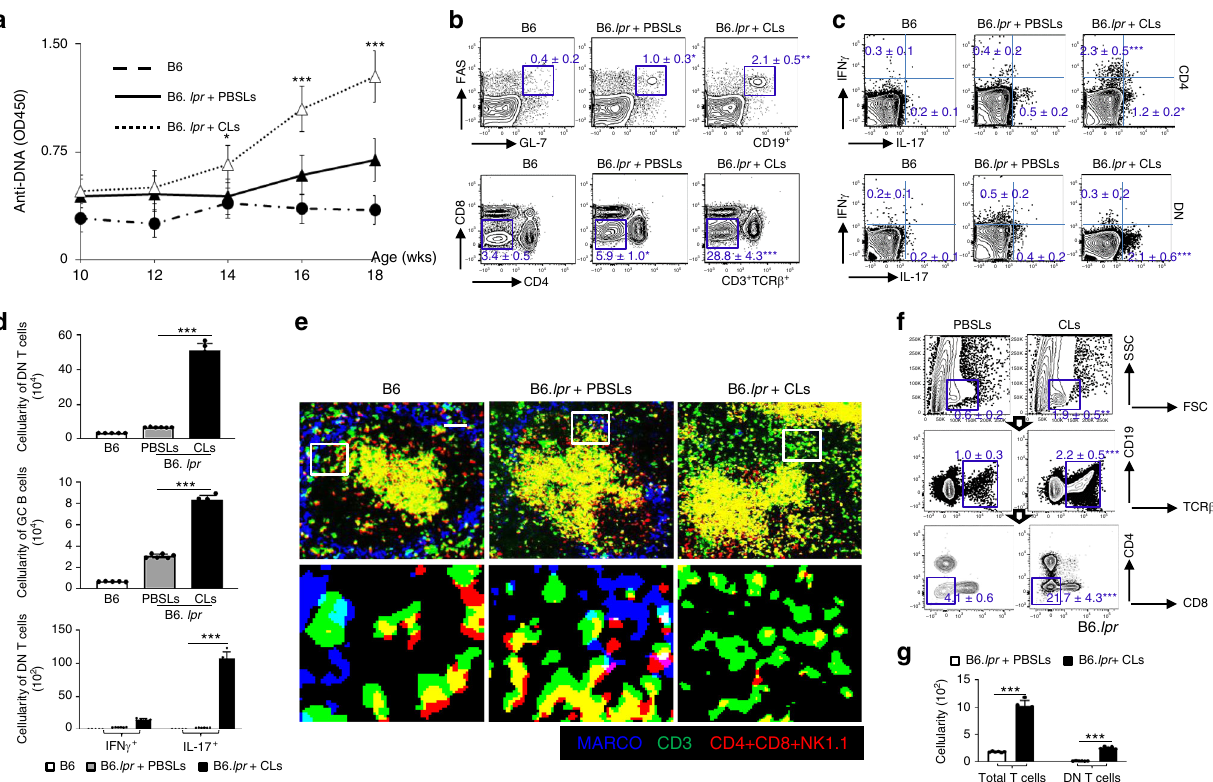
Fig. 1 Marginal macrophage depletion promotes the expansion of DN T cells. a – g Age-matched female B6. lpr mice were treated with either PBS-loaded control liposomes (PBSLs) or Clodronate liposomes (CLs, 100 µ g/mouse) every other week for 2 months starting at 10 weeks of age. Naive B6 mice were used as controls. n = 5 – 6 mice per group for two independent experiments. a ELISA analysis of anti-dsDNA IgG in sera from indicated mice. b Flow cytometry quantization of the percentage of germinal center (GC) B cells and double-negative (DN) T cells in spleens from indicated mice. Upper: PNA + FAS + GC B cells (gated in CD19 + ); lower: CD4 − CD8 − NK1.1 − DN T cells (gated in CD3 + TCR β + ). c Flow cytometry quantitation of the percentage of IL-17 + and IFN- γ + CD4 T cells (upper) and DN T cells (lower) in spleens of indicated mice. d Bar graphs show absolute cell numbers of indicated cell population of spleens from mice with indicated treatment. e Representative immuno fl uorescent staining of MARCO + marginal zone macrophages (blue) and CD3 + (green) T cells that also showed negative staining for CD4, CD8, and NK1.1 (red) in the spleens from the indicated mice. Upper: magni fi cation, ×20. Scale bar: 50 µ m; Lower: digitally magni fi ed views of the boxed areas in the upper panels. f Flow cytometry quantitation of in fi ltrating T cells in kidneys of indicated mice. g Bar graphs show absolute cell numbers of indicated cell population of kidneys from mice with indicated treatment. Data represent the mean ± SEM, * P < 0.05, ** P < 0.01, ** P < 0.005 vs. indicated control, two-tailed Student ’ s t